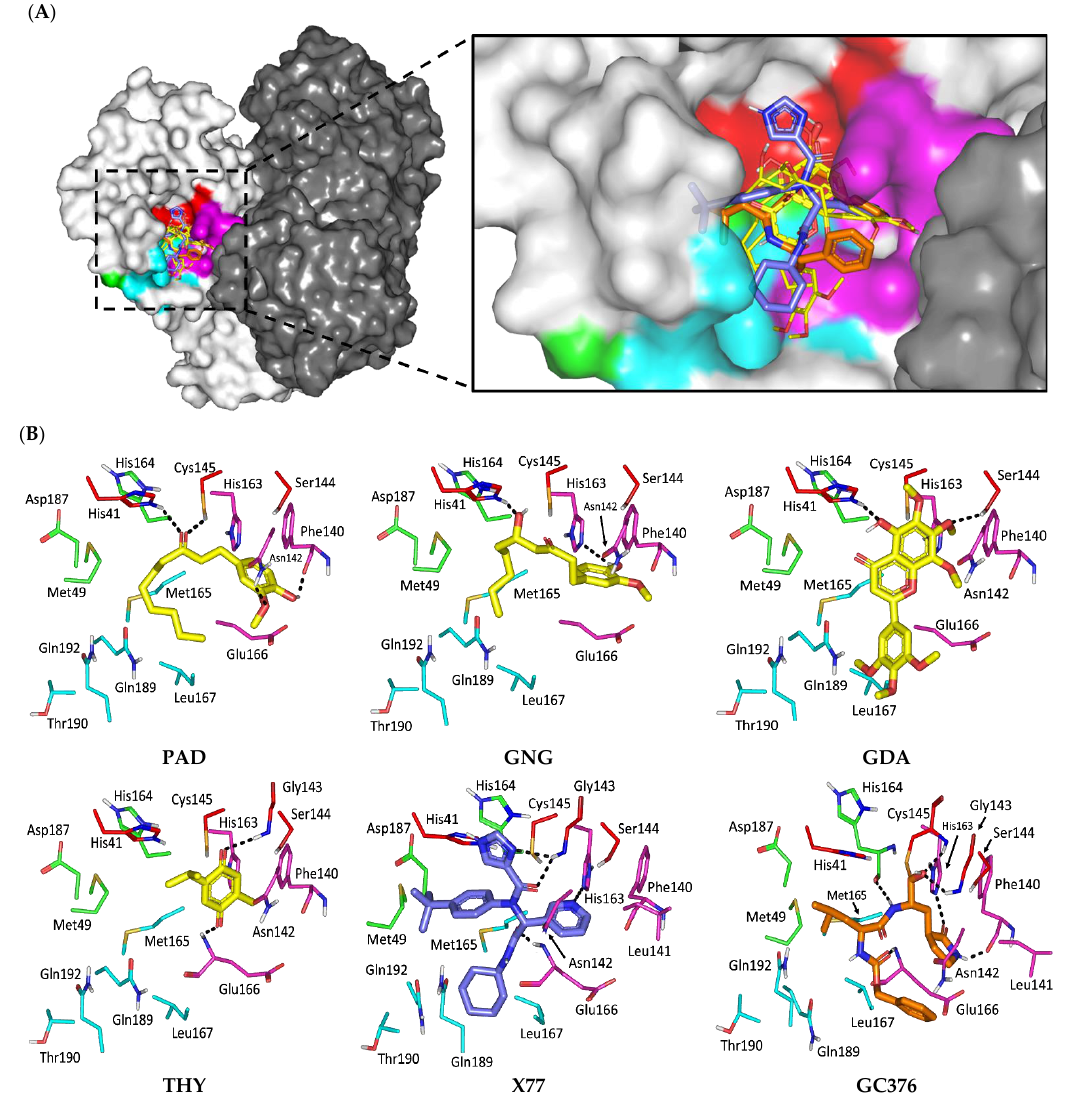
Figure 4. Ligand/M PRO binding modes and interactions. ( A ) Surface rendition of SARS-CoV-2 M PRO , with an overlay of docked isolated compounds (yellow lines) and potent reference (blue or orange sticks for X77 or GC376, respectively). The protein is colored in dark and light gray colors for protomer A and B, respectively, while the target binding subsites are shown in red, magenta, green, and cyan for S1 ′ , S1, S2, and S3 subsites, respectively; ( B ) Docked binding modes of investigated compounds (sticks), where residues (lines) only located within 5Å radius of bound ligands are displayed, labeled by sequence numbers, and colored based on respective subsite location. Polar interactions (hydrogen bonds) are shown as dashed black lines.